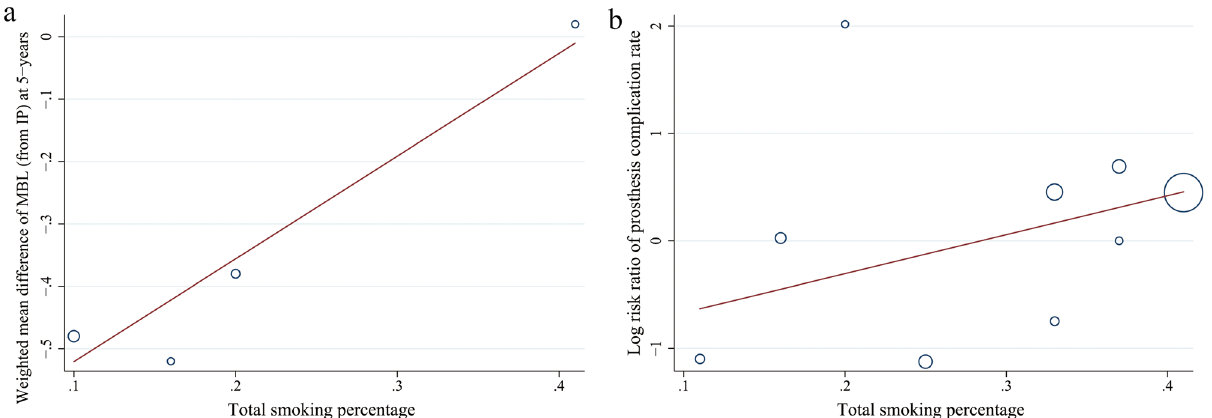
Figure 13. Meta-regression analyses. ( a ) Total smoking percentage had a positive correlation to the difference in mean of 5-year MBL from implant placement between two groups without statistical significance (coefficient: 2.787; p = 0.506); τ 2 = 0.196; I 2 = 87.45%; Adj R 2 = − 12.57%. ( b ) Total smoking percentage had a positive correlation to the RRs for prosthesis complication rates between two groups without statistical significance (coefficient: 2.937; p = 0.570); τ 2 = 0.000; I 2 =